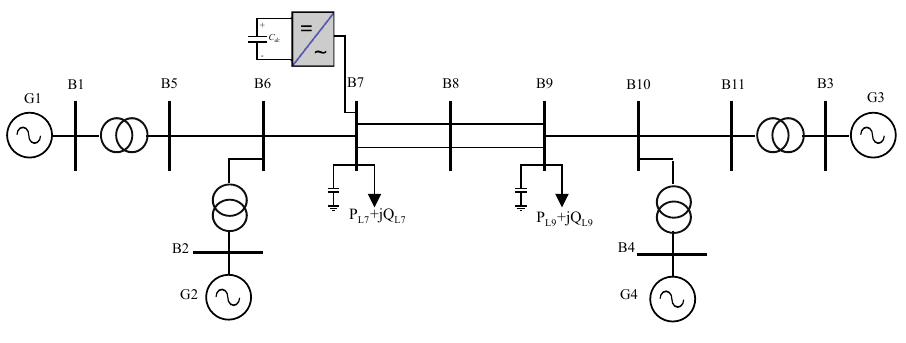
Figure 4. Two-area power system